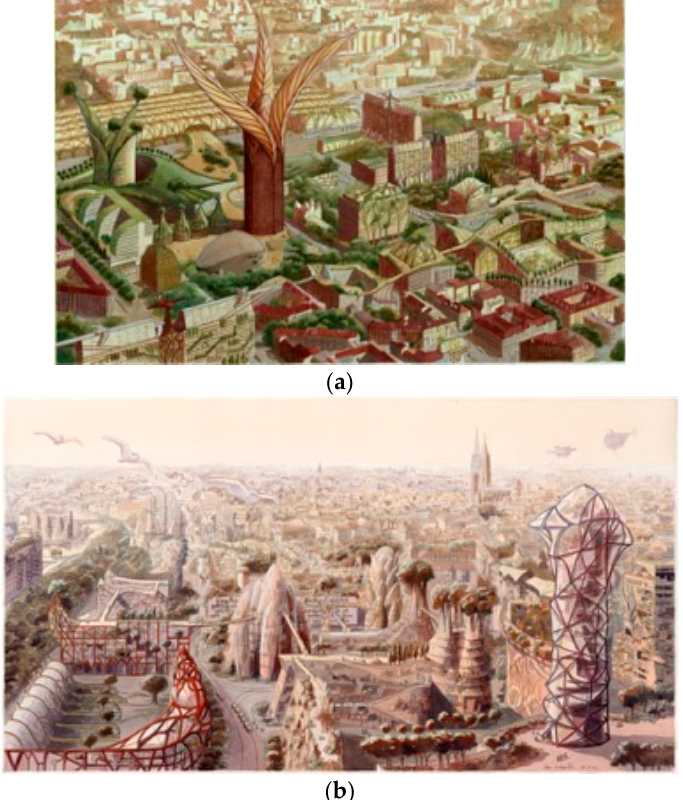
Figure 4. Vegetal cities, © Luc Schuiten. ( a ) Lyon in 2100, ( b ) Strasbourg in 2100.